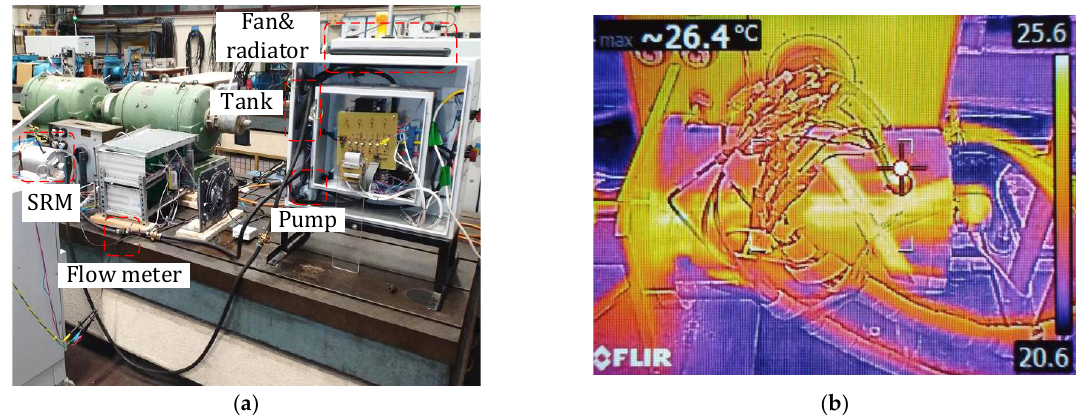
Figure 15. The test of the cooling system: ( a ) the setup of the cooling system; ( b ) the measured thermal result.